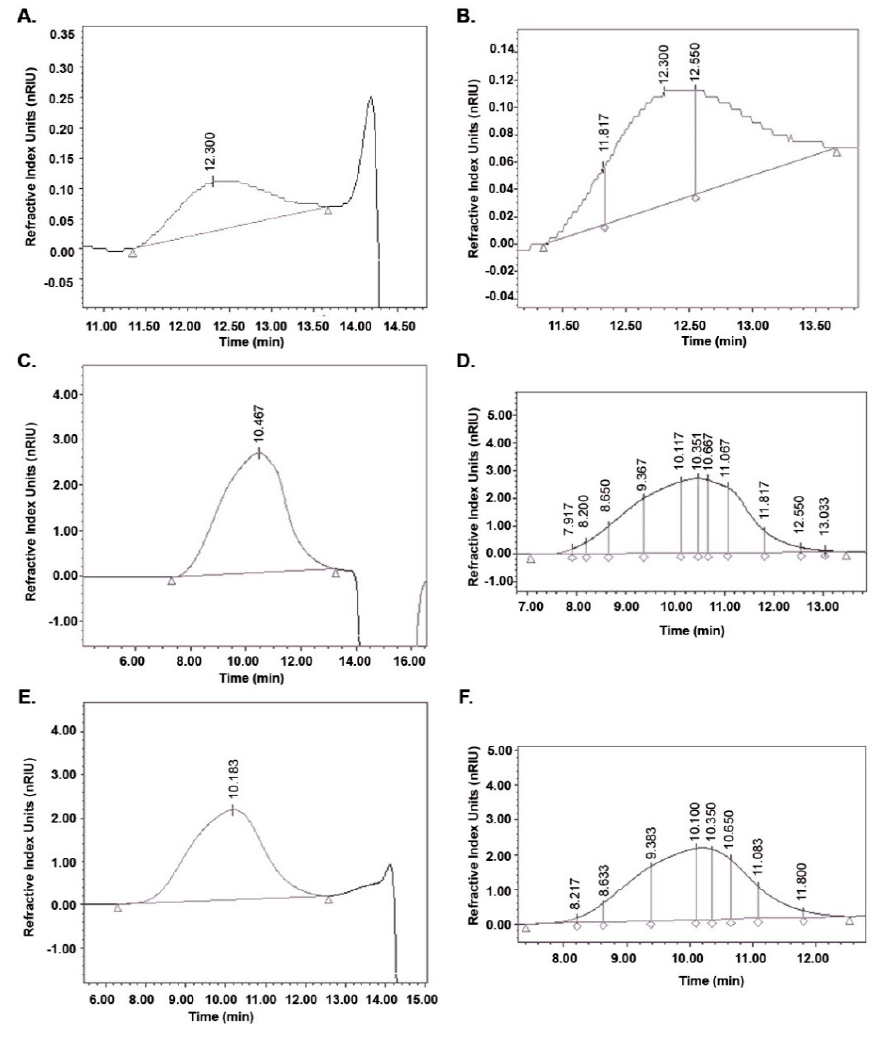
Figure 3. Chromatograms of HA in commercial samples and culture broth analyzed by HPLC- SEC. Chromatograms for serum, A ; capsule, C and culture broth, E . Differential molecular weight distribution calculated for serum, B ; capsule, D and culture broth, F .